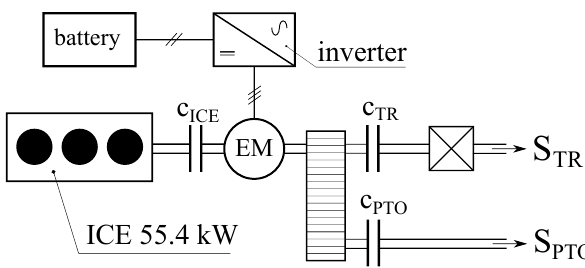
Figure 3. Hybrid powertrain architecture powered by the Internal Combustion Engine (ICE) and the Electric Machine